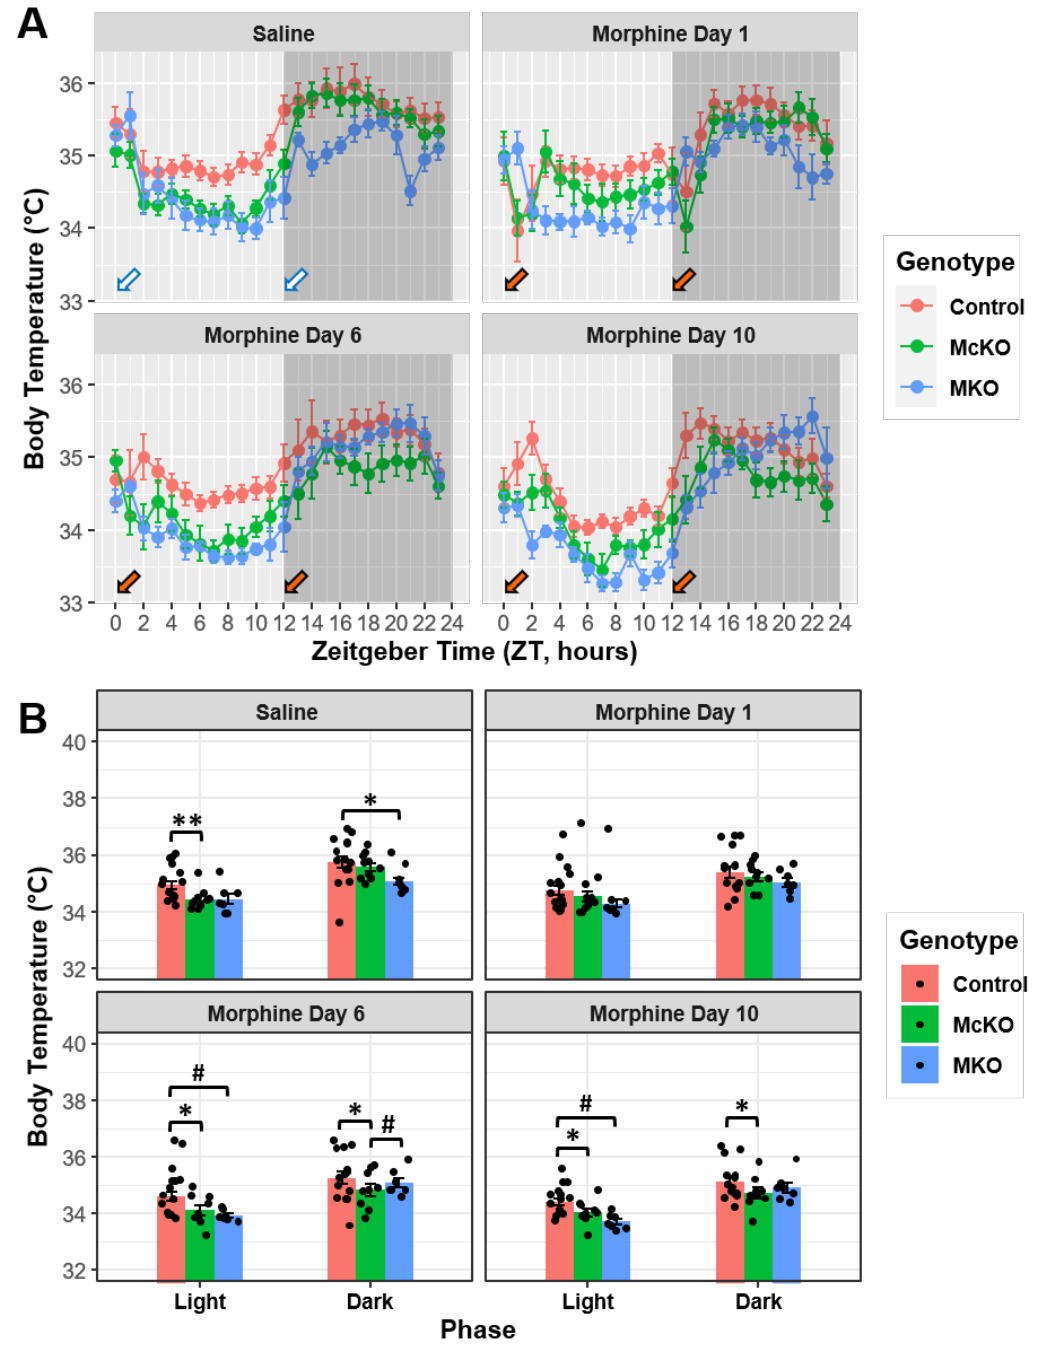
Figure 3. Morphine had differential effects on body temperature in control, McKO, and MKO mice across the morphine treatment paradigm. ( A ) Average body temperature plotted for control ( n = 14 – 15), McKO ( n = 9 – 10), and MKO ( n = 7) mice by hour (Zeitgeber Time) for different experimental days. Arrows indicate time of i.p. injection with either saline (white arrows) or 20 mg/kg of morphine (orange arrows). ( B ) McKO mice had a lower mean body temperature than control littermates on all experimental days except for the first day of morphine treatment. Three-way ANOVA (phase × genotype × experimental day) with a Tukey post hoc adjustment was performed on all pairwise comparisons. (# p < 0.05, * p < 0.01, ** p < 0.001). Data presented as mean ± SEM. When we dissected the changes in body temperature across experimental days, it appeared that chronic morphine tended to decrease overall body temperature during